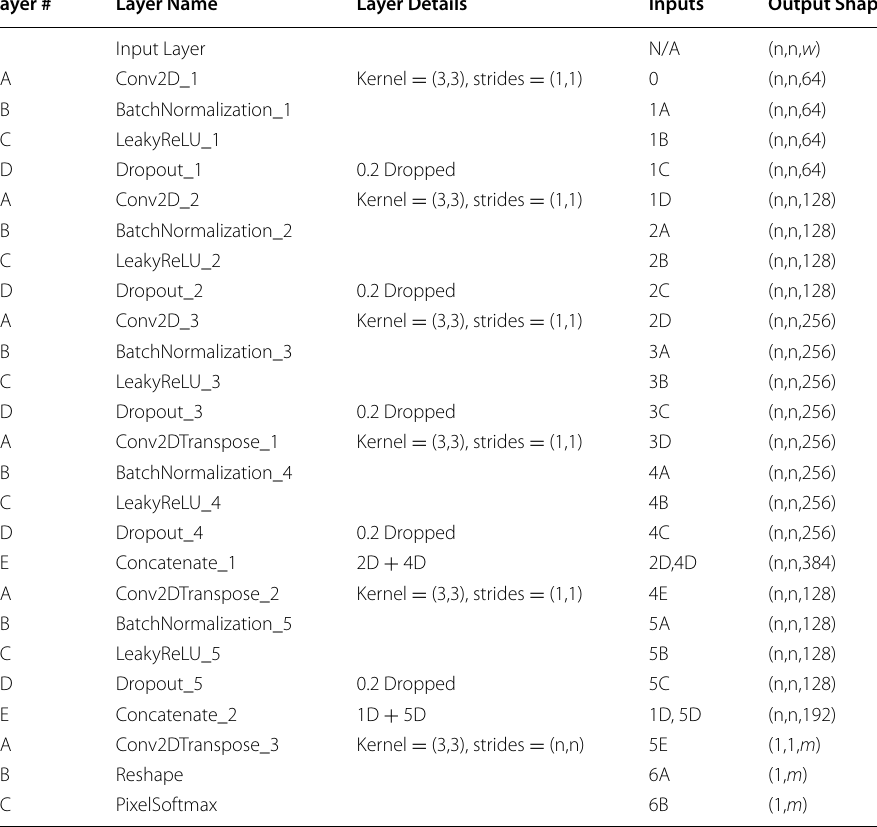
Table 2 The layer-wise summary of the single U-Net and the sub-classifiers used in the CEU-Net architecture. n x n is the patch size, w is the input spectral dimension, and m is the class size for the given